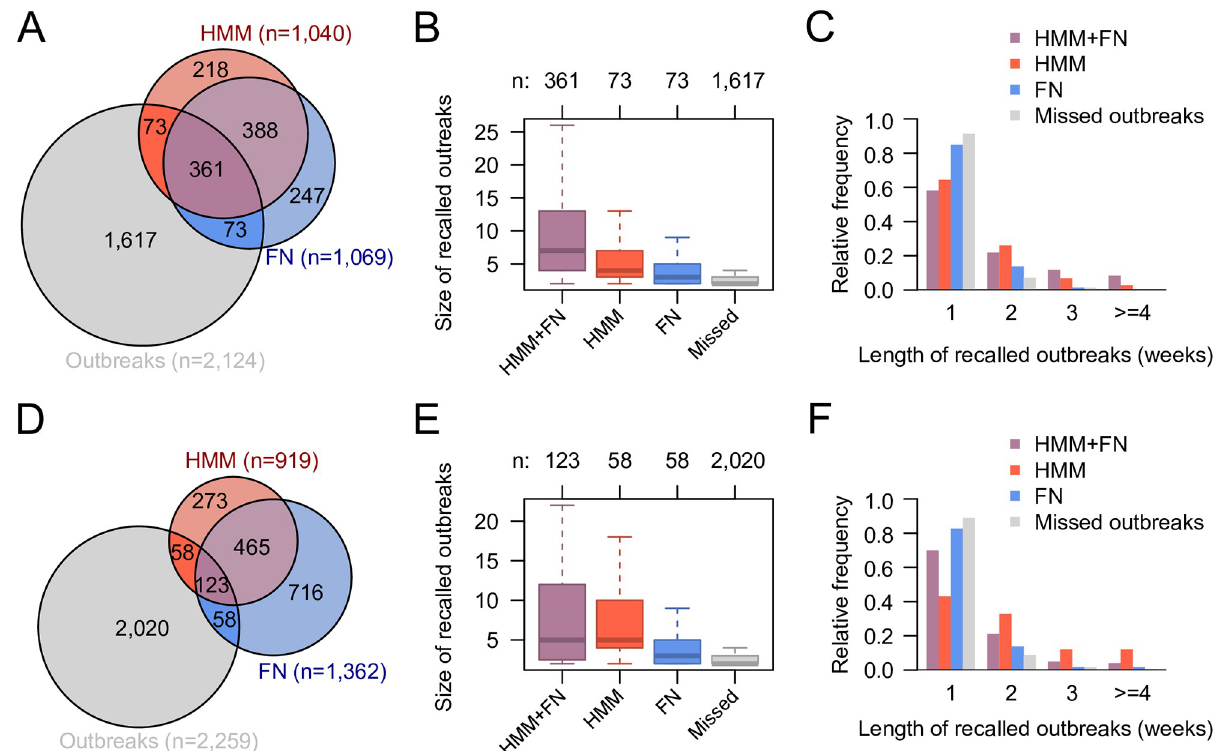
Fig 5. Comparison of outbreaks recalled by the supervised negative Binomial hidden Markov model (HMM) and the Farrington-Noufaily (FN) algorithm. (A) Venn diagram showing the overlap between outbreaks recalled by both methods. The FN algorithm was applied with cutoff 0.01 using threshold method ‘nbPlugin’. The cutoff for the HMM outbreak probability was chosen to get the same recall as the FN algorithm. (B) The number of cases in outbreaks recalled by both, one or none of the applied methods. (C) Distribution of the duration (in weeks) of outbreaks recalled by both, one or none of the applied methods. (D-F) The same as (A-C) for the Campylobacter data.